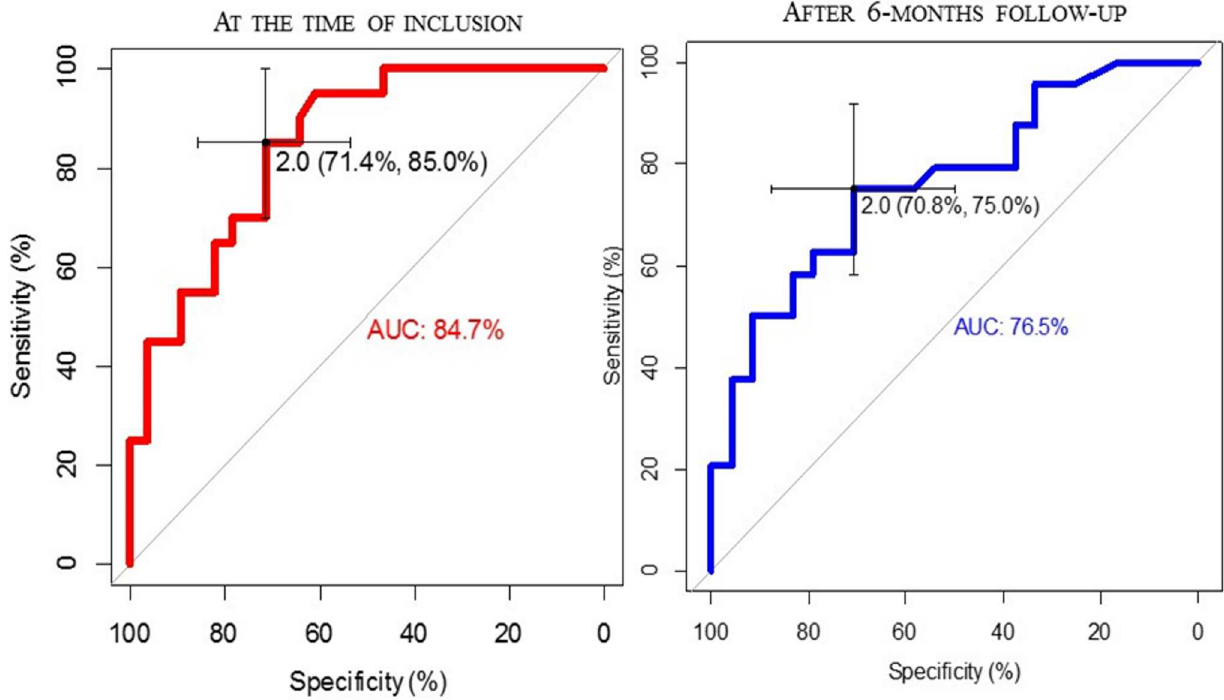
Fig 2. ROC analysis of IFX trough levels (TL) associated with current and long-term response.